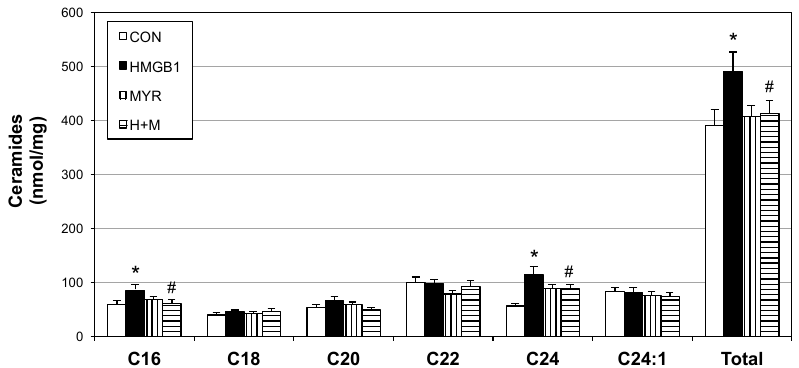
Figure 5. HMGB1 increases muscle ceramides. The 12–14-week old male mice received daily injections of placebo (CON), HMGB1 (1 μ g/day), myriocin alone (MYR; 3 μ g/kg thrice weekly), or myriocin + HMGB1 for 14 days ( n = 6). Following the treatment period, ceramides were analyzed from soleus. * p < 0.05 vs. CON. # p < 0.05 vs. HMGB1.